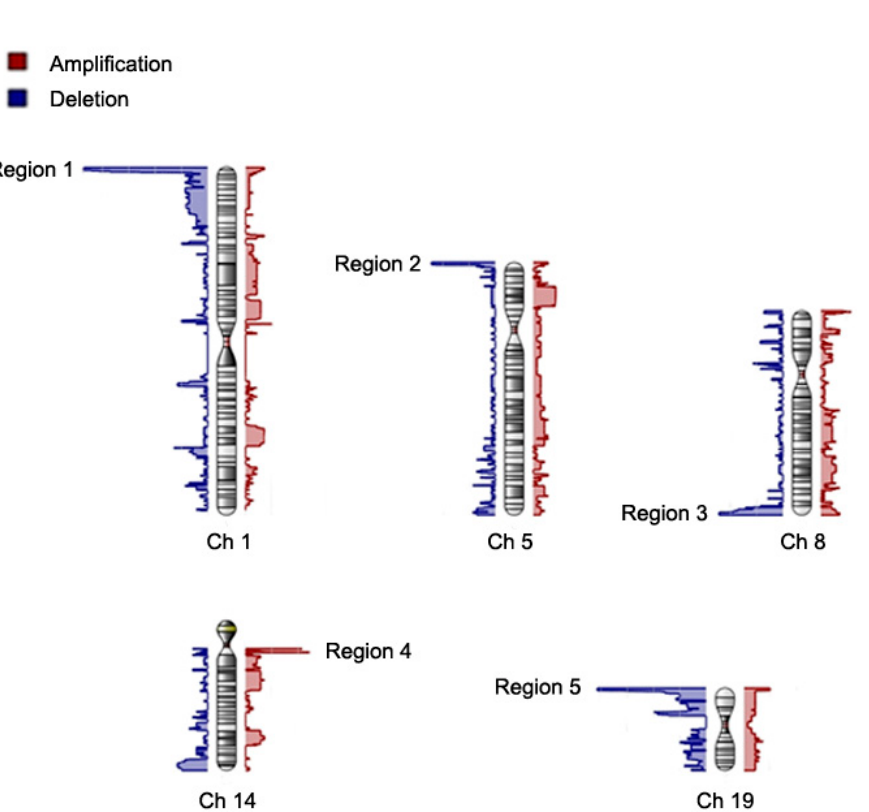
Figure 1. The chromosome view of genome-widely identified copy number variations including deletions and amplifications. The identified copy number variations are filtered using criteria of presence of total copy number aberration in more than 15% of the patients and minor allele frequency more than 0.15. After filtering, there are 5 significant regions (regions 1–5) in chromosome 1 (Ch 1), 5 (Ch 5), 8 (Ch 8), 14 (Ch 14) and 19 (Ch 19) in which the copy numbers are significantly different between atrial fibrillation (AF) patients with thromboembolic stroke and controls. X axis represents the number of aberration patients. Blue and red regions represent deletion and amplification, respectively.